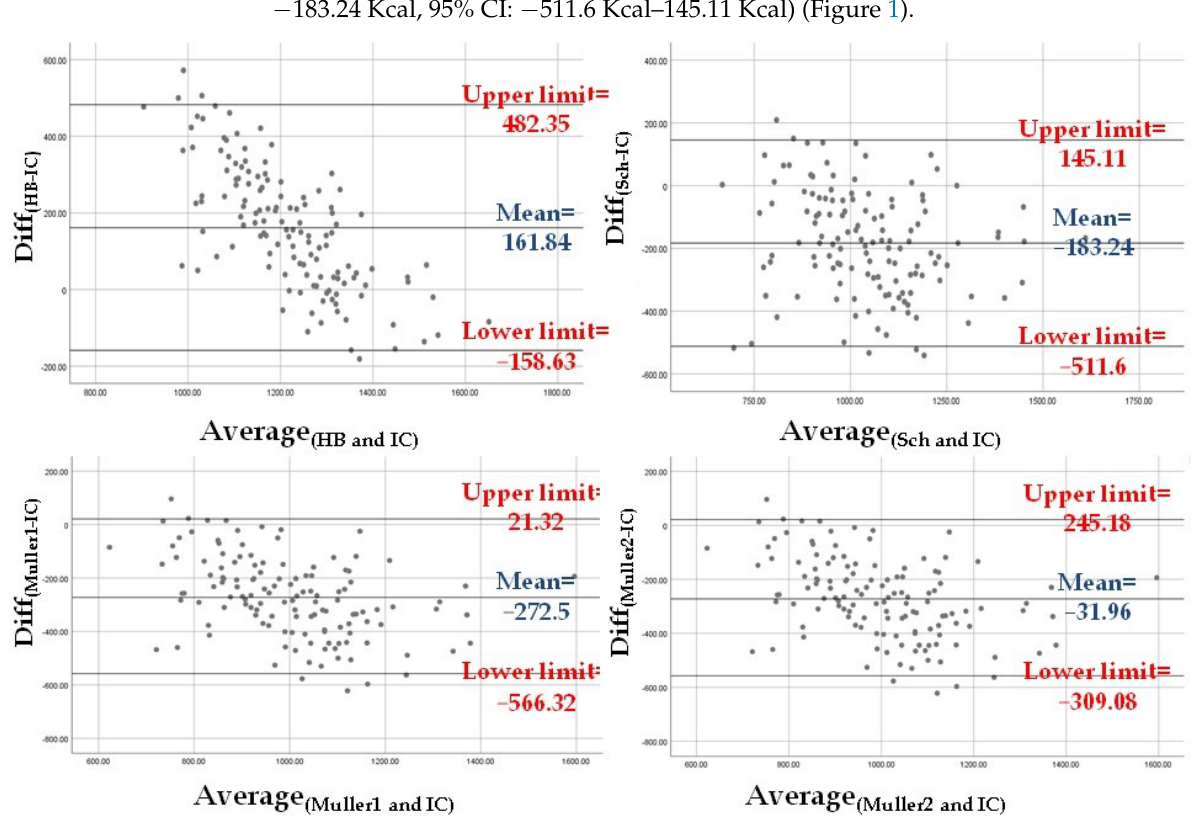
Figure 1. The Bland–Altman plots show that the REE estimated with the Muller equation that requires BIA measurements (Muller 2) is in agreement with REE IC the most, followed by the REE estimated with the Schebendach